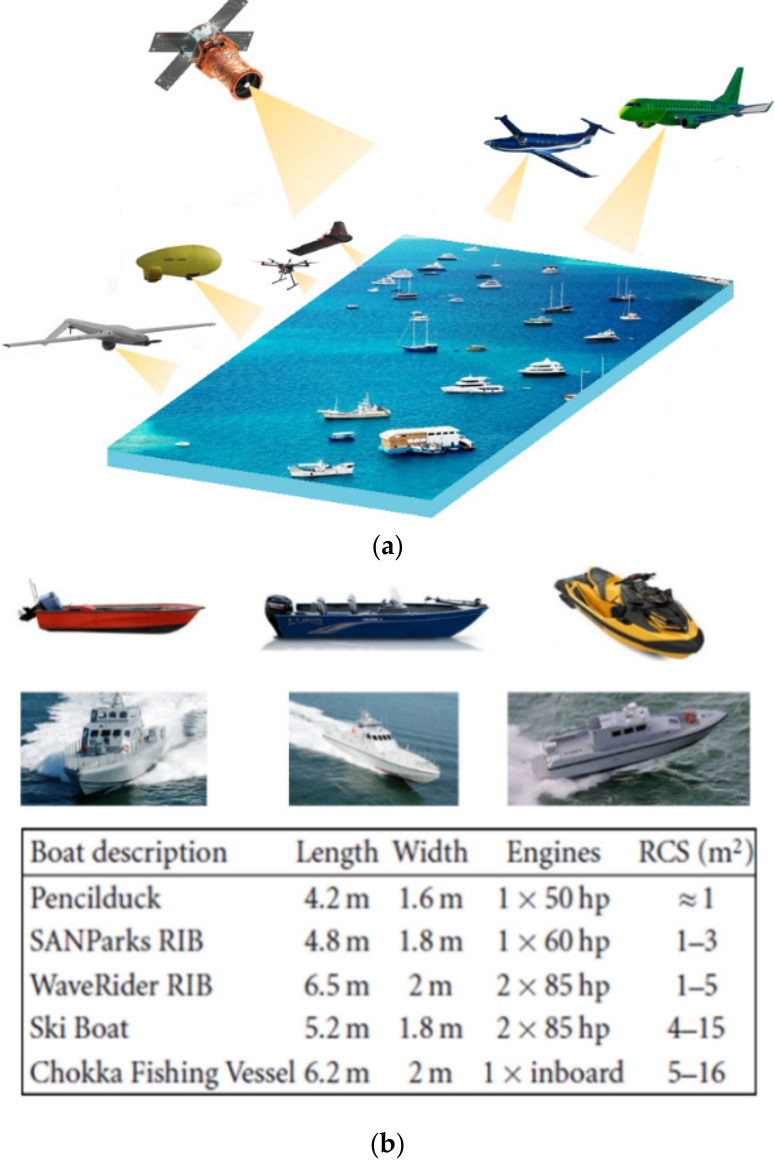
Figure 1. ( a ) An illustration of satellite, manned aircraft, and UAV remote sensing platforms; ( b ) small and medium maritime vessels.